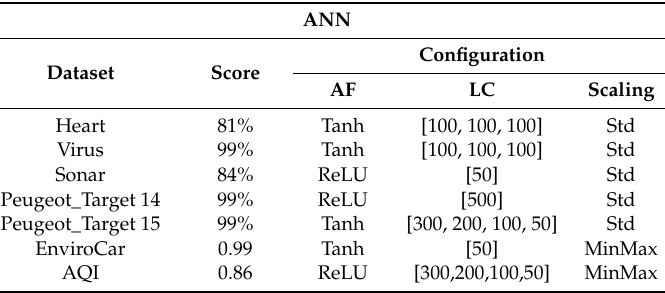
Table 21. ANN performance and configuration for PCA = None.